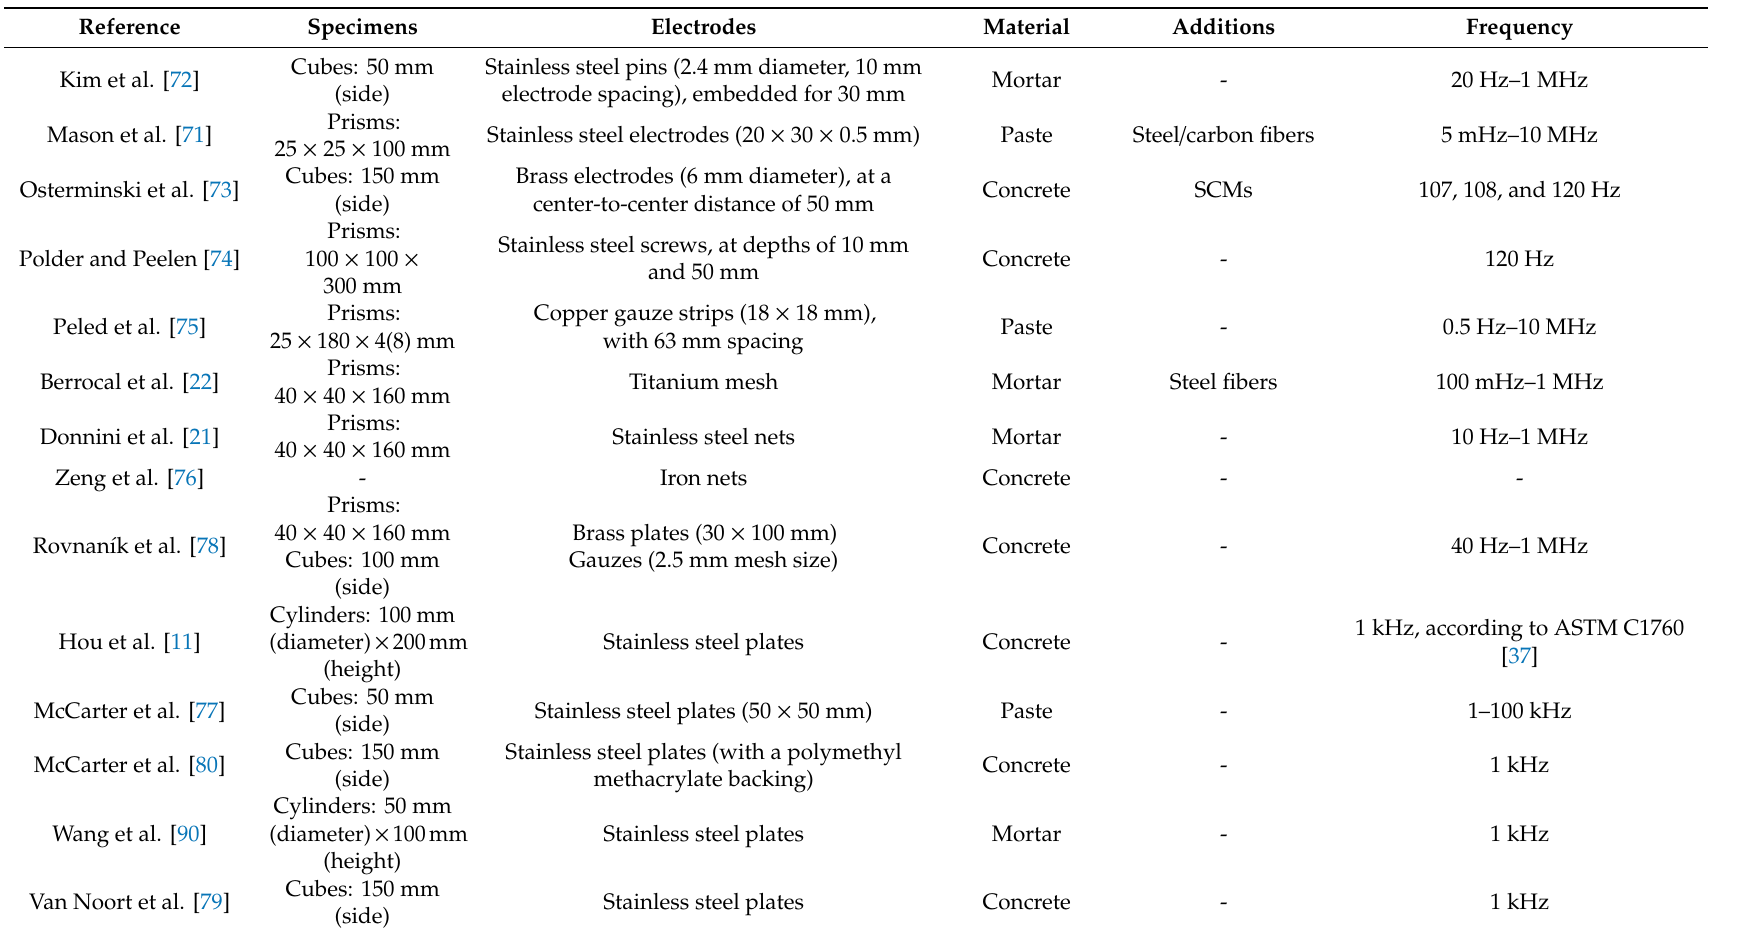
Table 3. AC measurements with 2-point probe